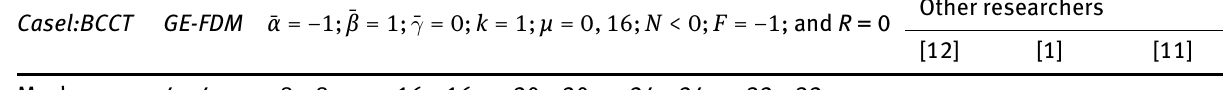
Table 1: Moment and deflection (cm) coeflcients for bending combined with compression for constant thickness (BCCT).